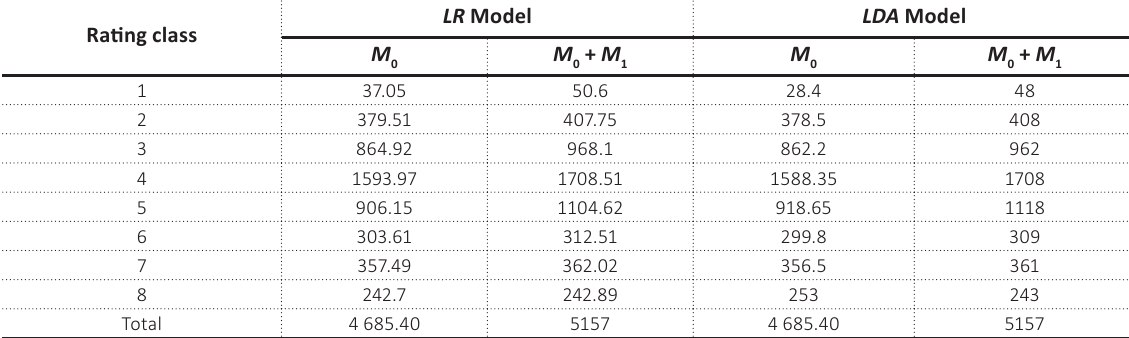
and ( M + M ) per rating class (million MAD) 0 0 1